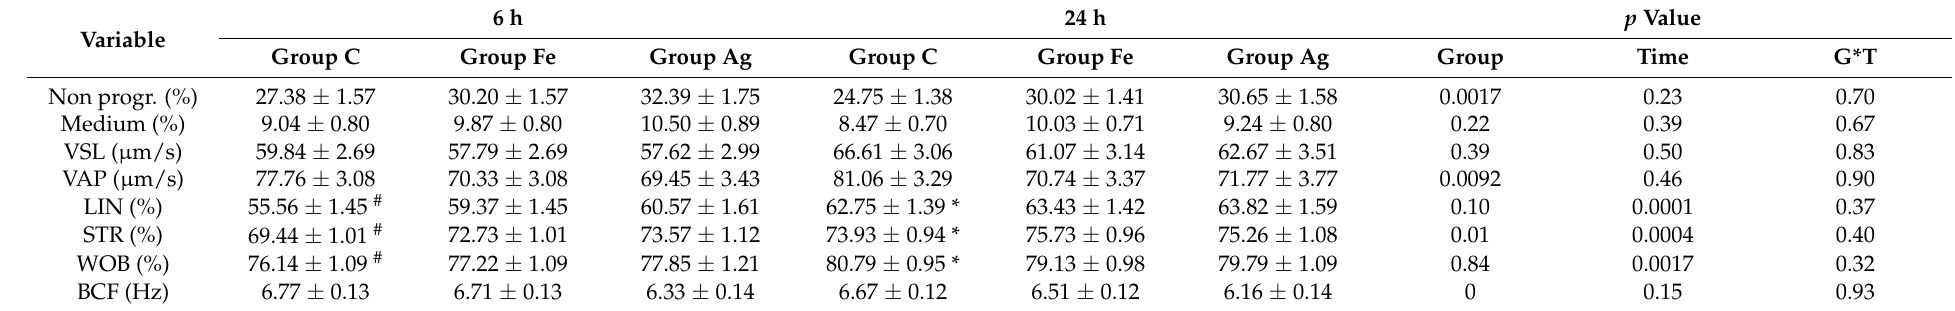
Table 1. Computer-assisted sperm analyzer (CASA) kinetics (LSmeans ± SEM) of liquid ram semen ( n = 21) preserved at 15 ◦ C for 6 h and 24 h post treatment with Fe 3 O 4 and Ag / Fe nanoparticles (NPs).